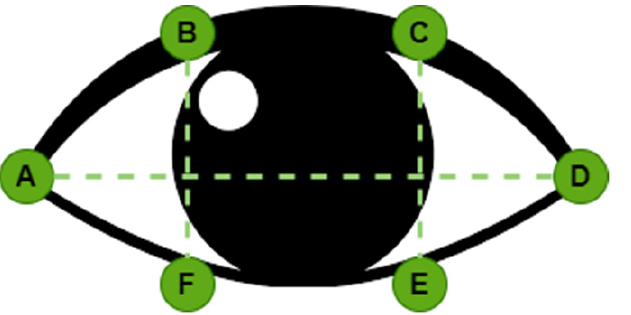
Figure 6. Eye landmarks. Two points (B and C) on the upper eyelid, two points (F and E) on the lower eyelid, and two points (A and D) on the two corners of the eye.